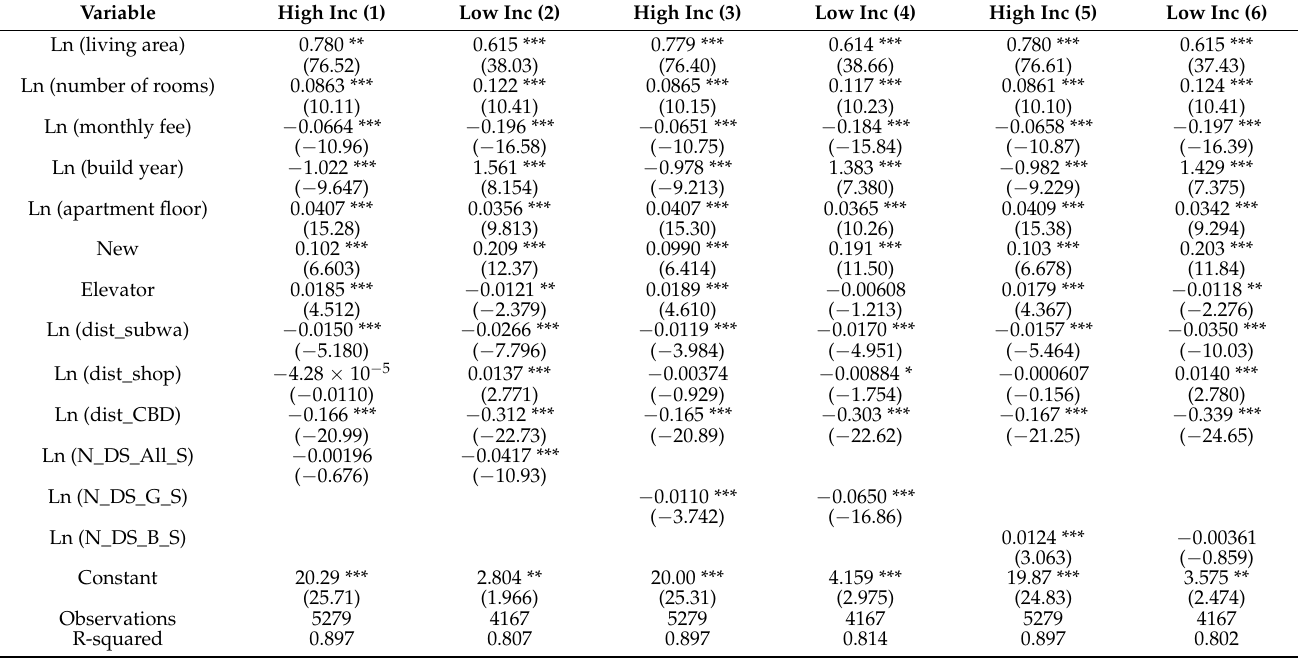
Table A2. HPM results are controlled by income for Measure 2.